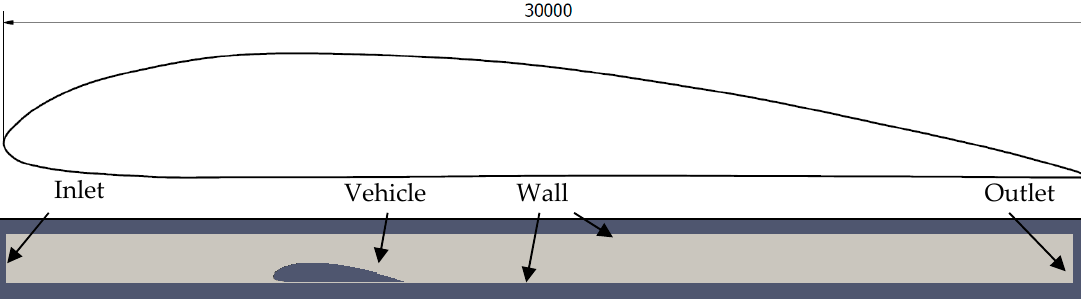
Figure 1. The N-10 airfoil shape used as a base for the considered vacuum vehicle and its position in the tunnel. Numerical geometry used for the aerodynamic calculations.